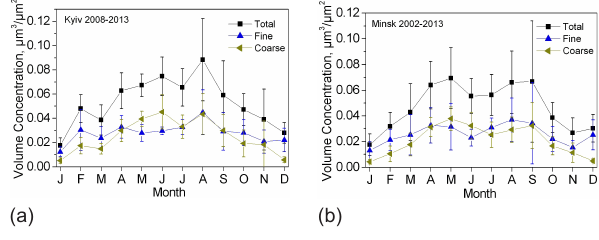
Figure 3. Seasonal behavior of aerosol volume concentration of to- tal, fine- and coarse-mode particles over the (a) Kyiv and (b) Minsk AERONET